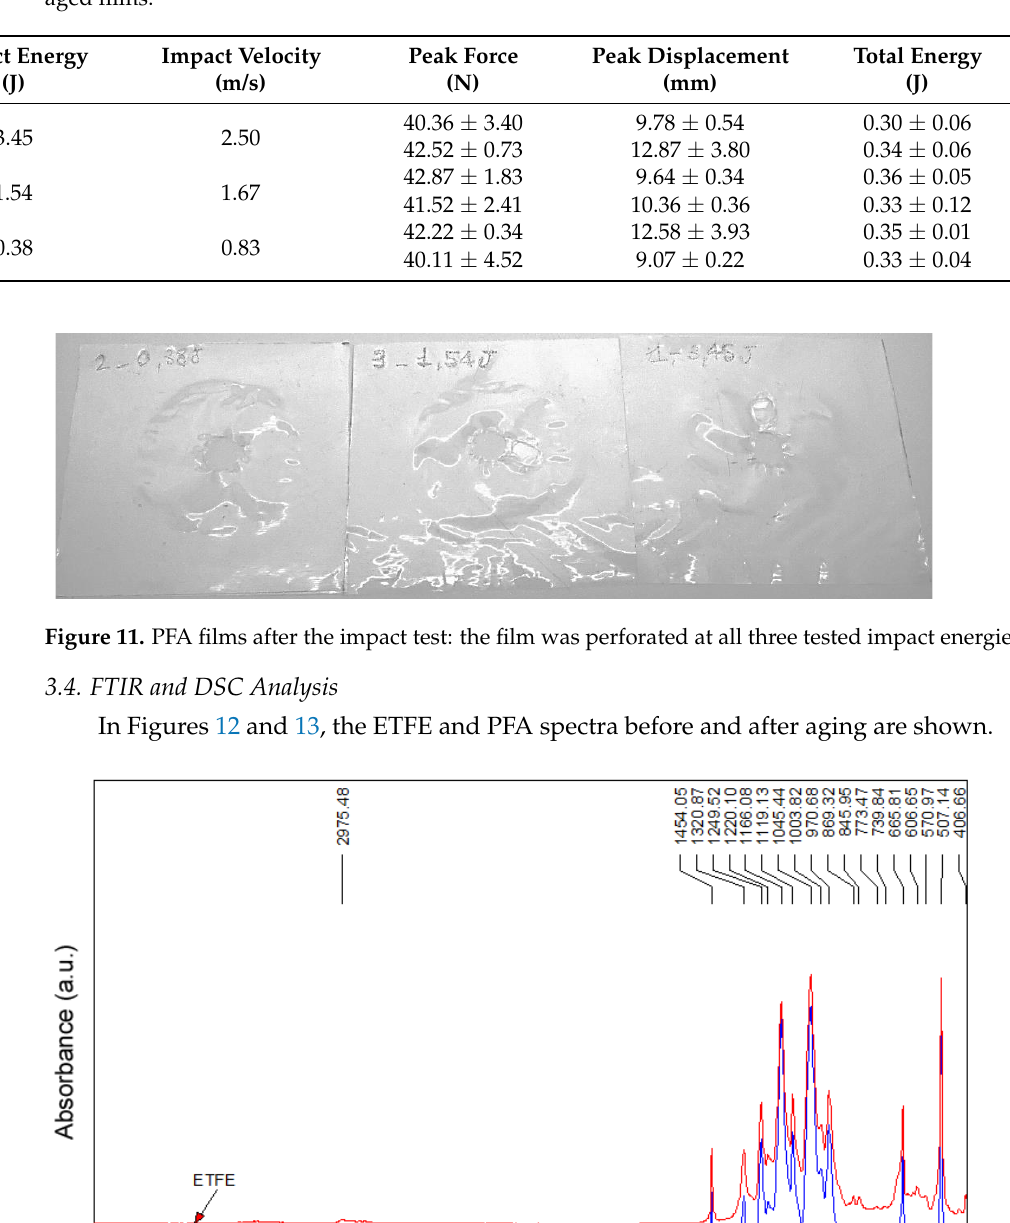
Figure 13. FTIR spectra of PFA films before and after aging. In the PFA film, the main effects shown are due to the CF 2 vibrations (at 1200 and 1145 cm −1 ), but, after aging, the spectrum (given in Figure 14) showed the presence of OH groups (3349 cm − 1 ) and the absorbance of C=O groups (1743 cm −1 , 1654 cm −1 , and 1589 cm −1 ) related to the COOH groups, due to the degradation of the molecular chains during the aging process [12].